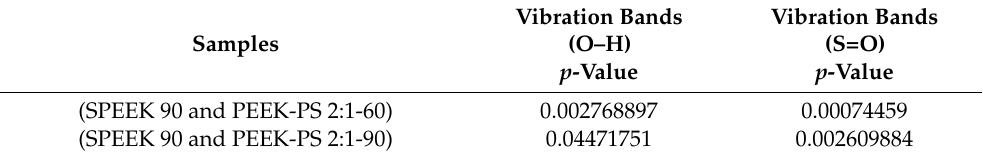
Table 2. T-test applied to the vibration bands at O–H and S=O: comparison between the p -values of SPEEK 90 and PEEK-PS 2:1-60, and SPEEK 90 and PEEK-PS 2:1-90. All tests were performed in triplicate ( n = 3). For p -value < 0.05, the result is considered significant, and is assumed that the sample means are not statistically equal. In the case of p -value > 0.05, the result is not considered significant, and the sample means are statistically the